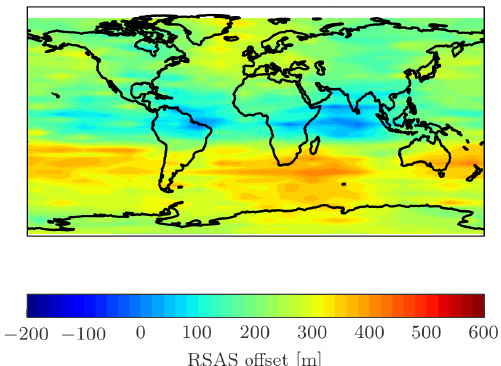
Figure 3. RSAS offsets globally binned in latitude and longitude for the time period beginning in 2004 and ending in 2010. Values where the OSIRIS optics temperature is less than 18 ◦ C are